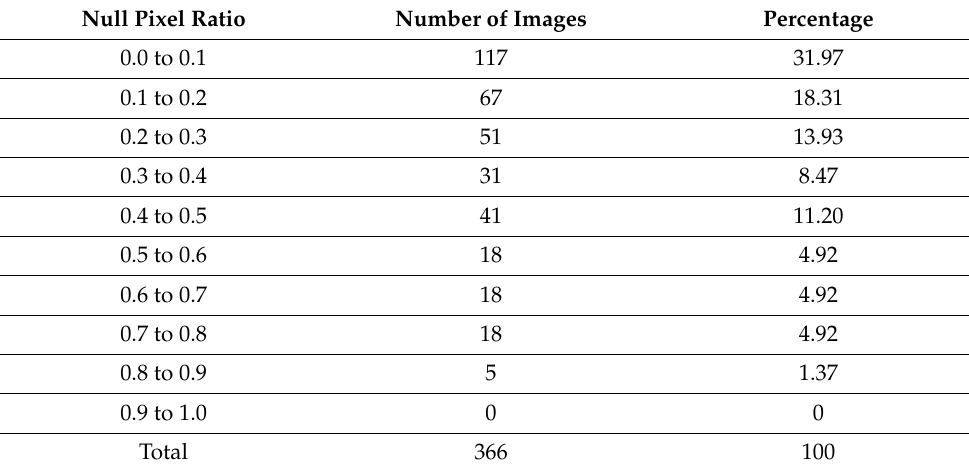
Table 7. Null pixel ratio of GK2A daily SST in 2020.